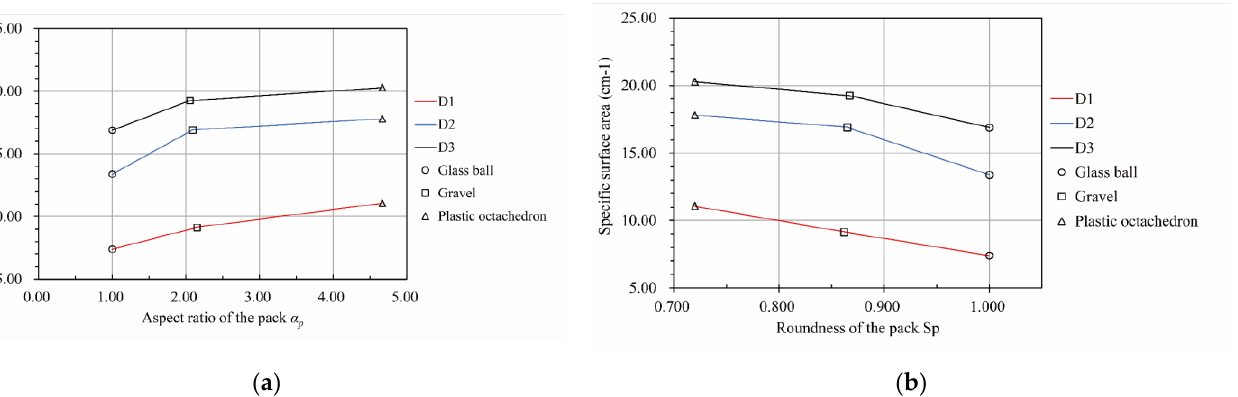
Figure 16. The relationship between the particle pack shape and the specific surface area of the pore network of the pack. ( a ) The relationship between the specific surface area of the pore network and the aspect ratio of the pack. ( b ) The relationship between the specific surface area of the pore network and the roundness of the pack.